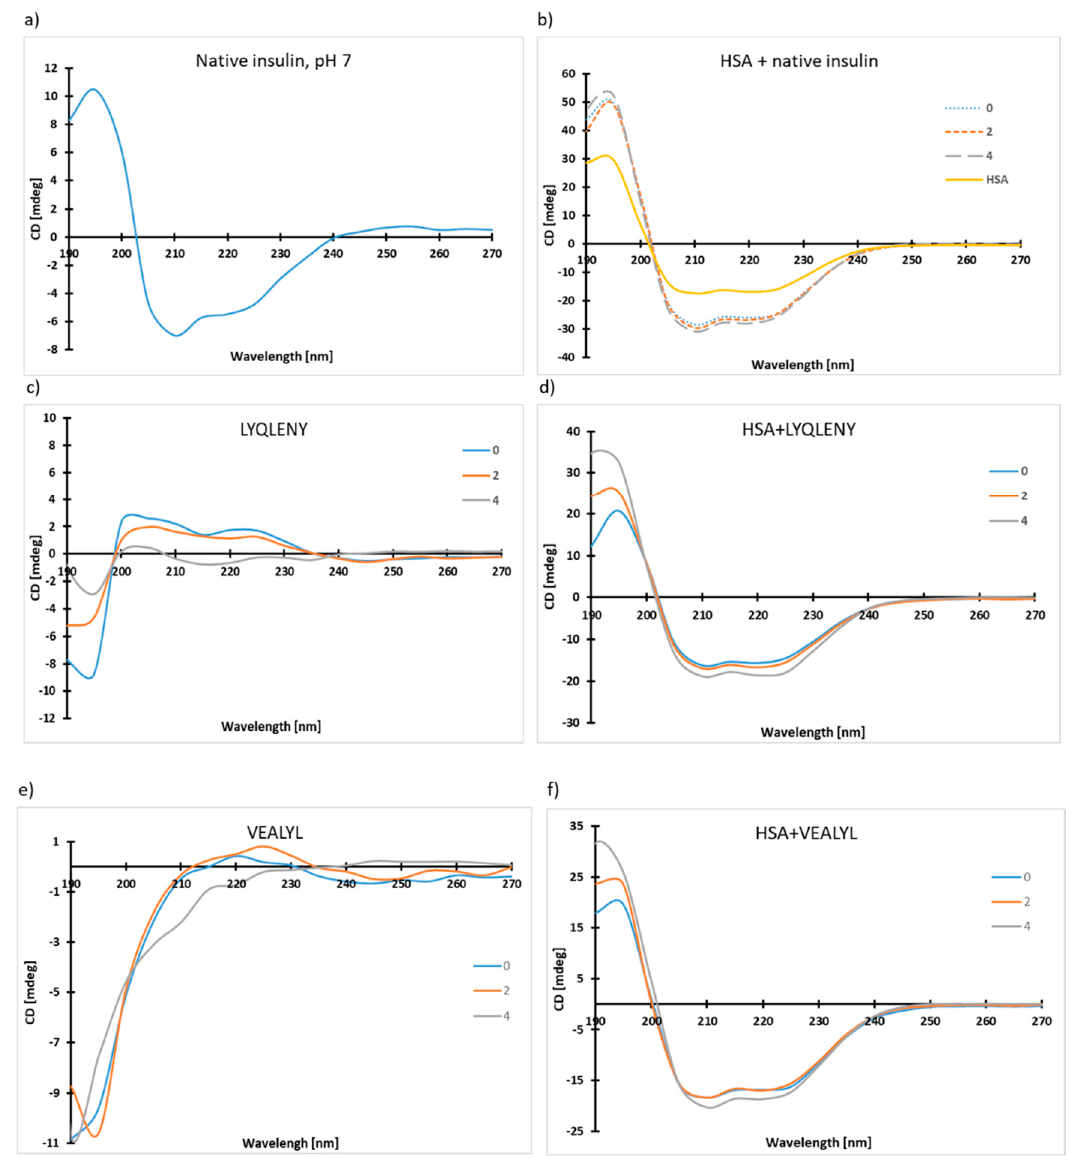
Figure 9. CD spectra recorded for native insulin ( 4 ) and hot spot fragments ( 5 – 6 ) in the presence of HSA and without serum protein: ( a ) native insulin, ( b ) HSA-insulin complex, ( c ) H-LYQLENY-OH ( 5 ), ( d ) HSA- LYQLENY complex, ( e ) H-VEALYL-OH ( 6 ), ( f ) HSA-VEALYL complex. [HSA], [insulin] [LYQLENY], [VEALYL] = 0.1 mg/mL.